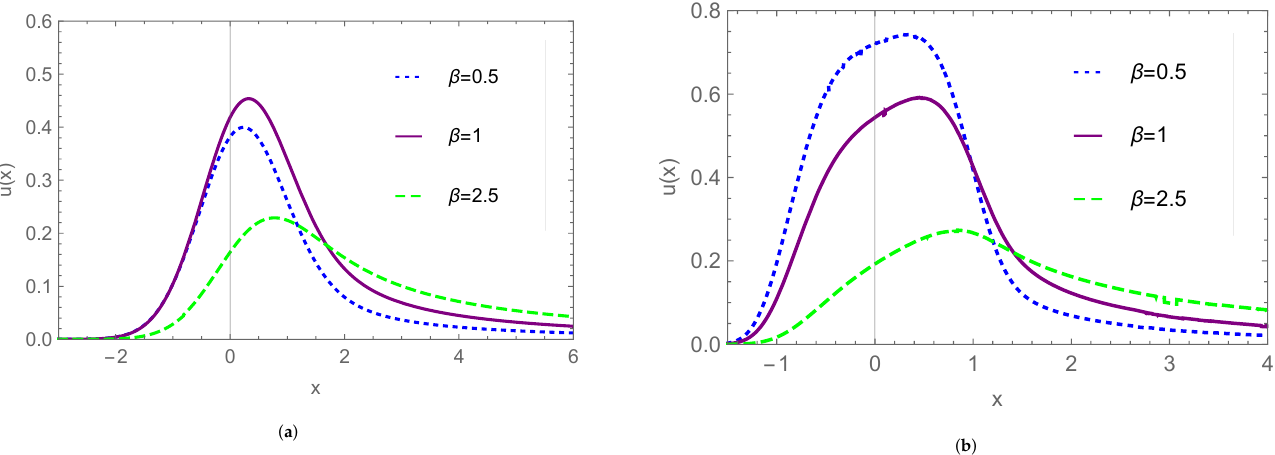
Figure 4. Equation (29) for different values of β , ν = 1 f ( x ) = e − x 4